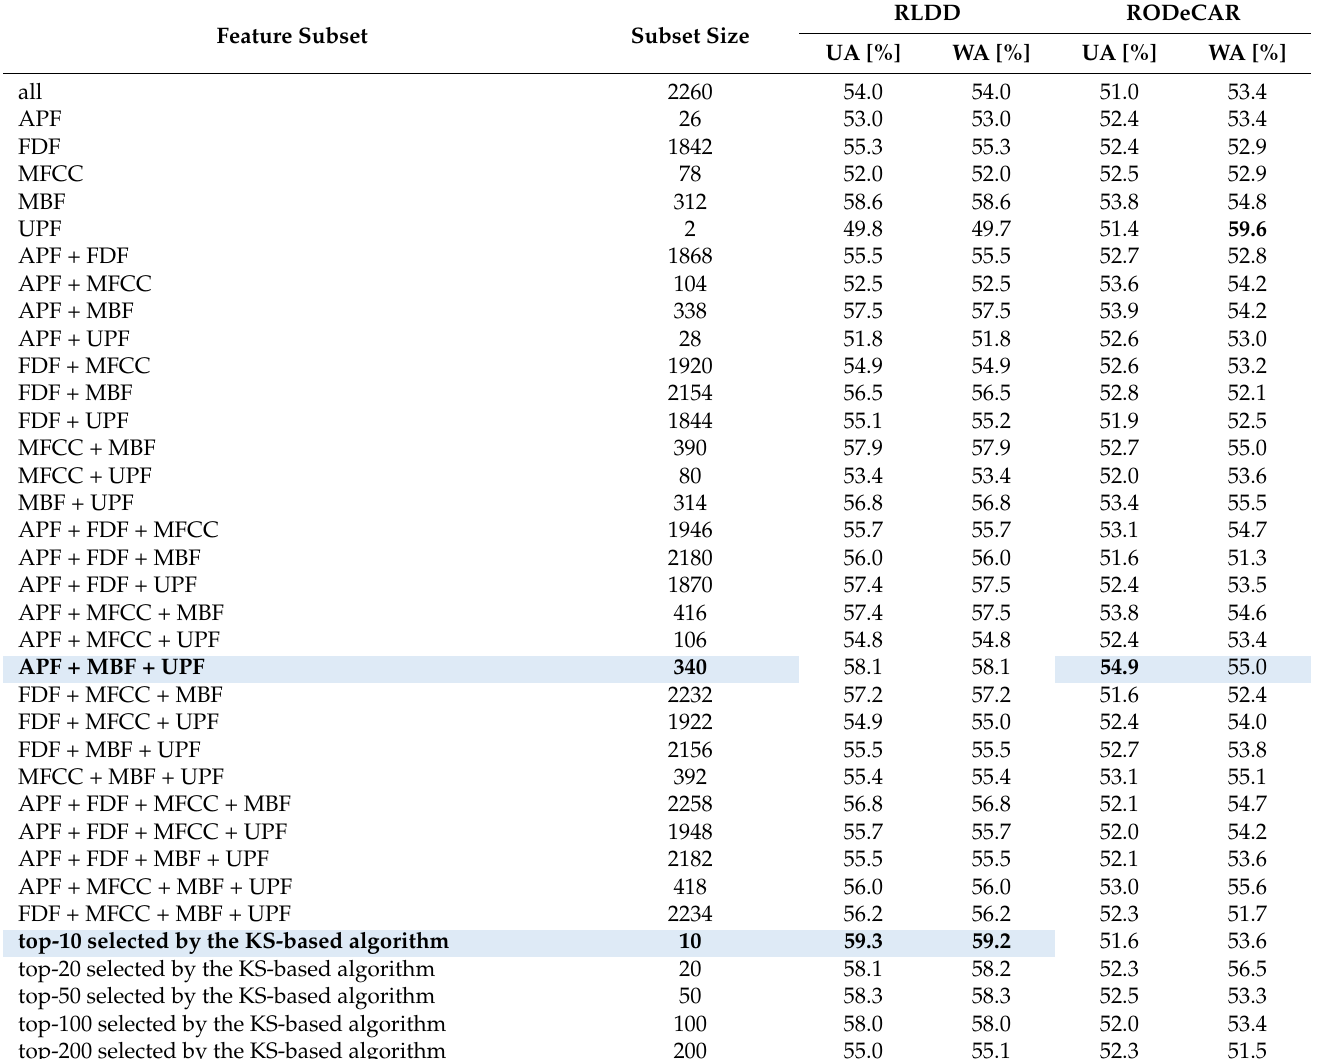
Table 9. MLP-based DSD cross-validation performance vs. feature subsets–RLDD and